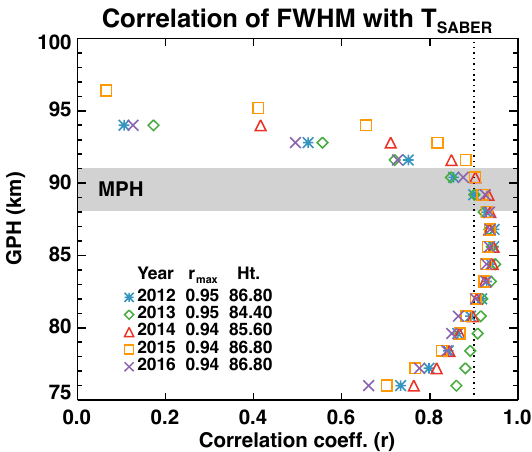
Figure 3. The height profile of correlation coefficient of the FWHM and SABER temperatures in 2012–2016. The height information of the maximum correlation coefficient and its value in each year are also summarized. The dotted vertical line indicates a correlation coefficient of 0.9, and the gray shaded box denotes the height range of the MPH variation during the observation